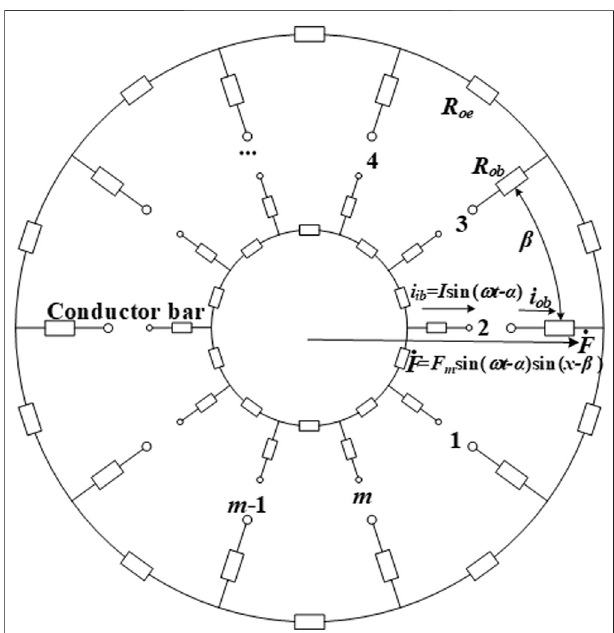
FIGURE 2 | Equivalent topology of